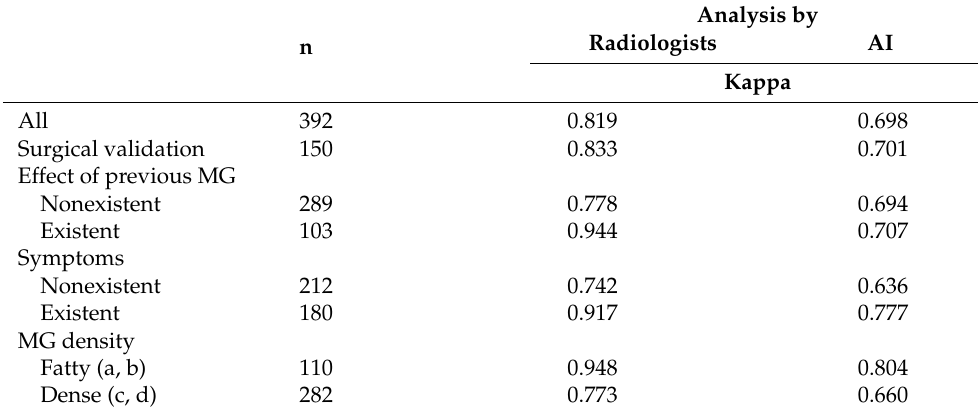
Table 3. Concordance of lesion location between mammography and pathology.